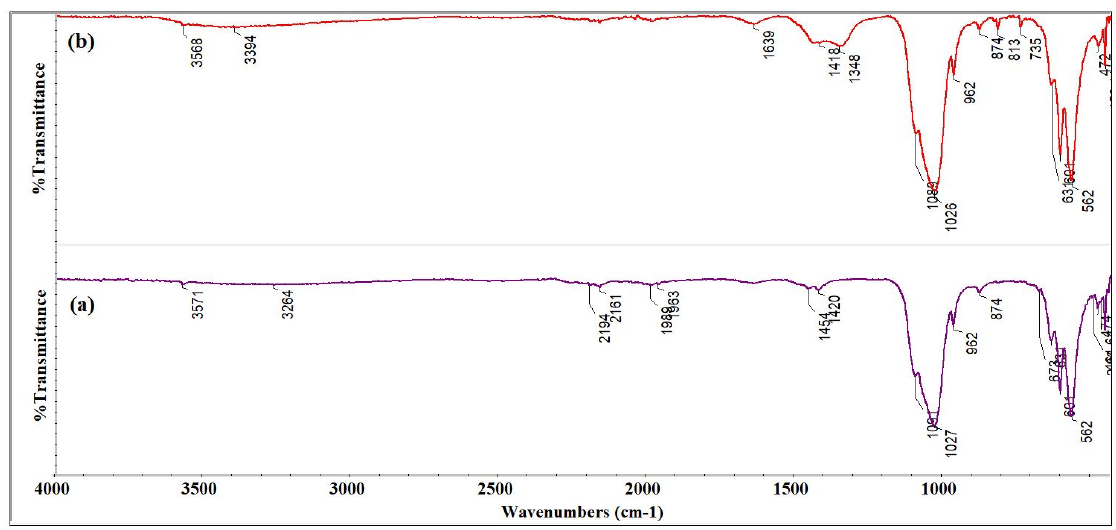
Figure 5. The Fourier transform infrared spectra characteristics of the HAp samples before ( a ) and after ( b ) the decontamination experiments.